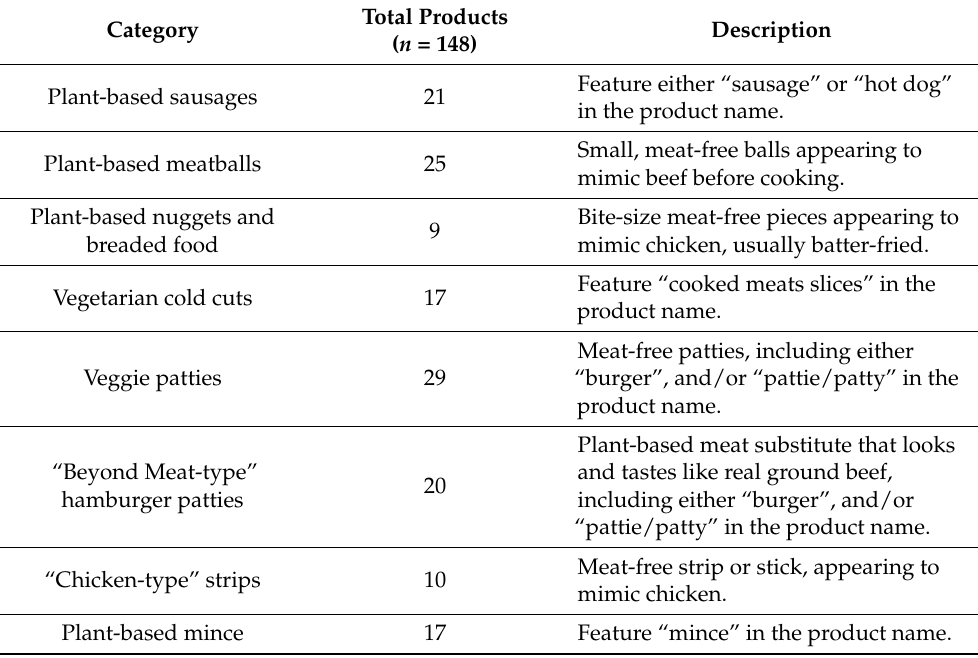
Table 3. Classification of plant-based product categories.